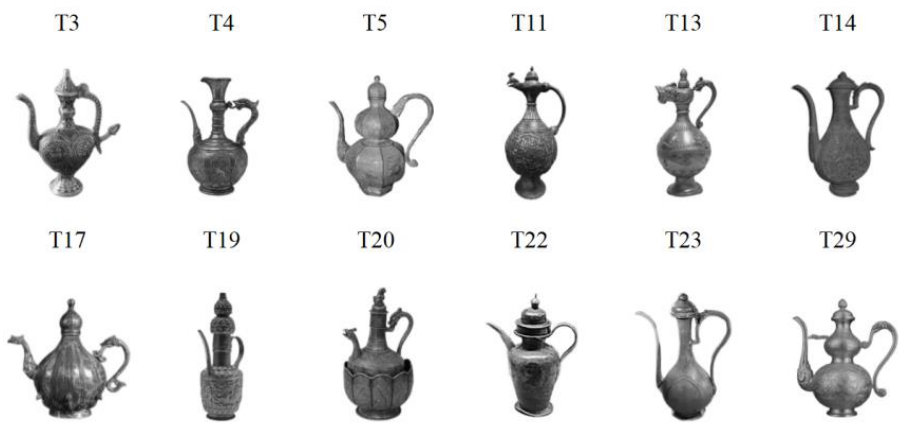
Figure 4. Representative sample illustration.